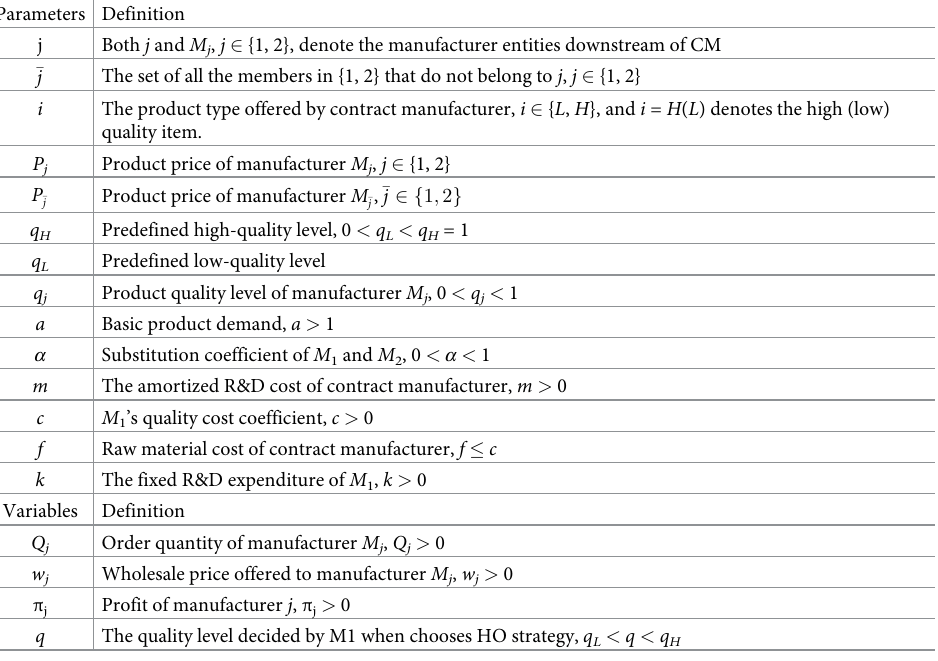
Table 3. Parameters and variables and their definitions.